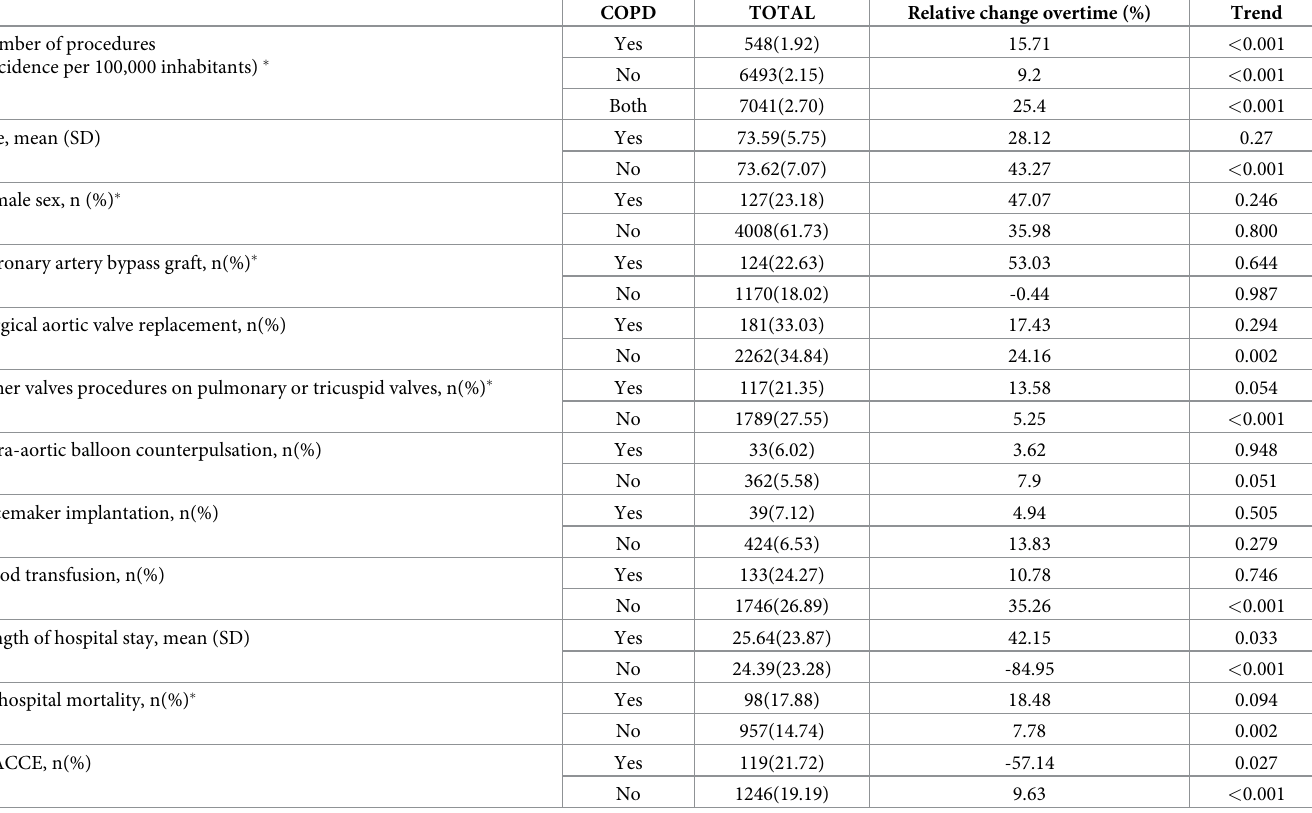
Table 4. Incidence, sociodemographic and clinical characteristics of patients hospitalized that underwent a bioprosthetic mitral valve replacement in Spain from 2001 to 2015 according to COPD